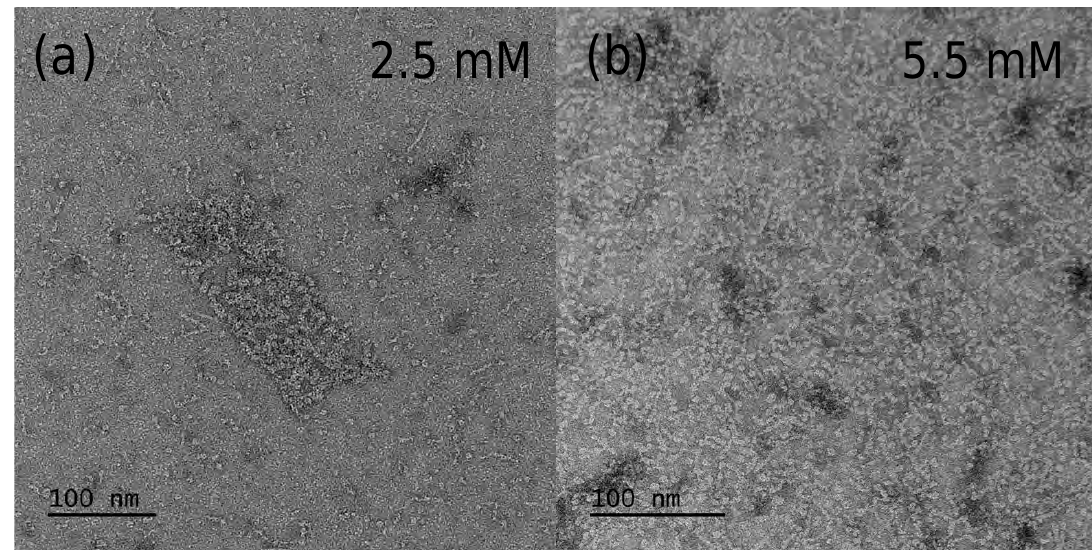
Figure 4. Transmission electron microscopy (TEM) images of aescin solutions with concentrations of ( a ) 2.5mM and ( b ) 5.5mM. The samples were deposited on TEM grids, stained and dried at 6 ◦